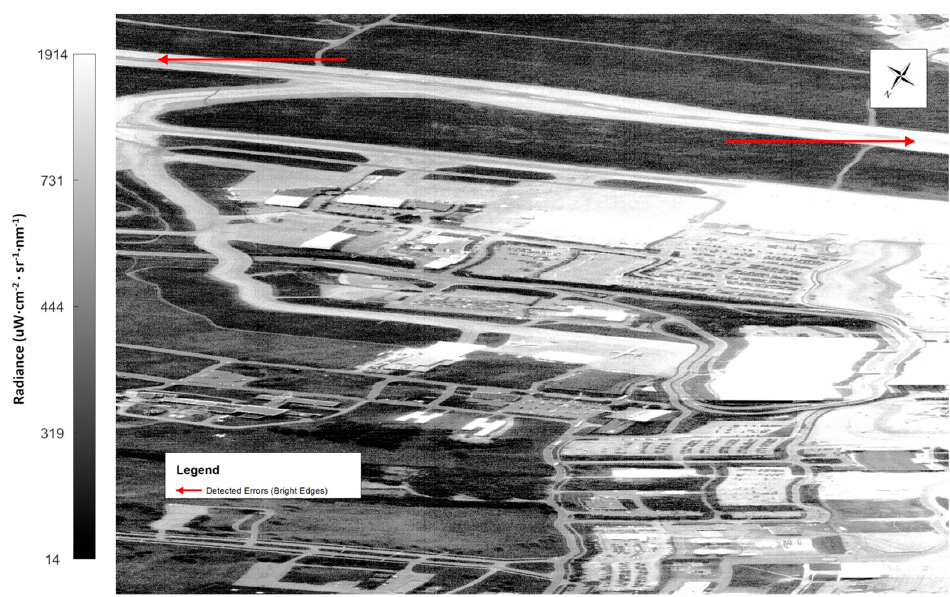
Figure 15. Histogram-equalized CASI imagery (24 June with the refined processing) at 393.068 nm. The asphalt road along the south side of the image was brightest along the edge pixels. These errors in the data are highlighted by the red arrows and were less noticeable in the imagery that was generated from the refined processing.